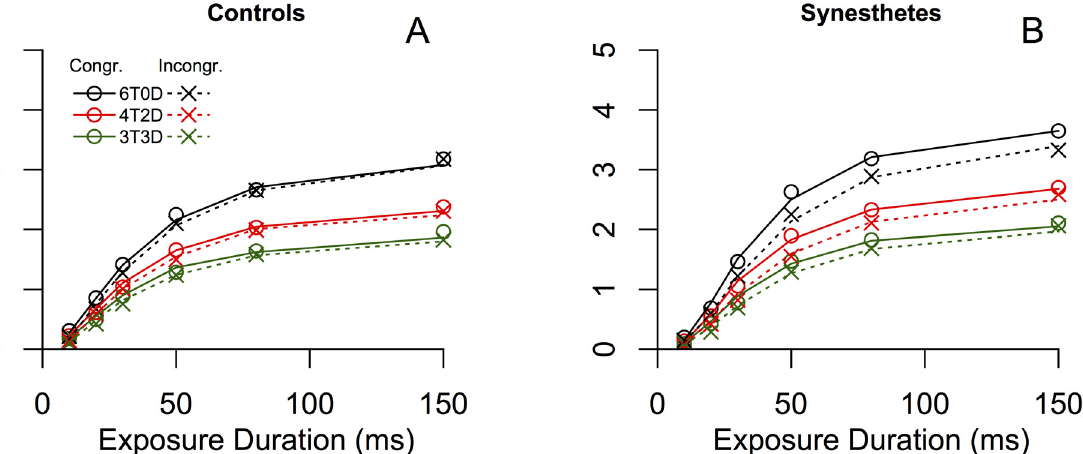
Fig 6. Average observed and modeled performance by target-to-distractor ratios as a function of exposure durations. Congruent trial performance is denoted by ∘ and incongruent performance by ×. TVA-fits for congruent trials are shown by the solid lines and fits to incongruent trials, by the dashed lines. Colors denote the ratio of targets and distractors in the briefly presented displays; black: 6 targets and no distractors, red: 4 targets and 2 distractors, green: 3 targets and 3 distractors. A. The results and fits by TVA of the control participants. B. The results and fits by TVA of the